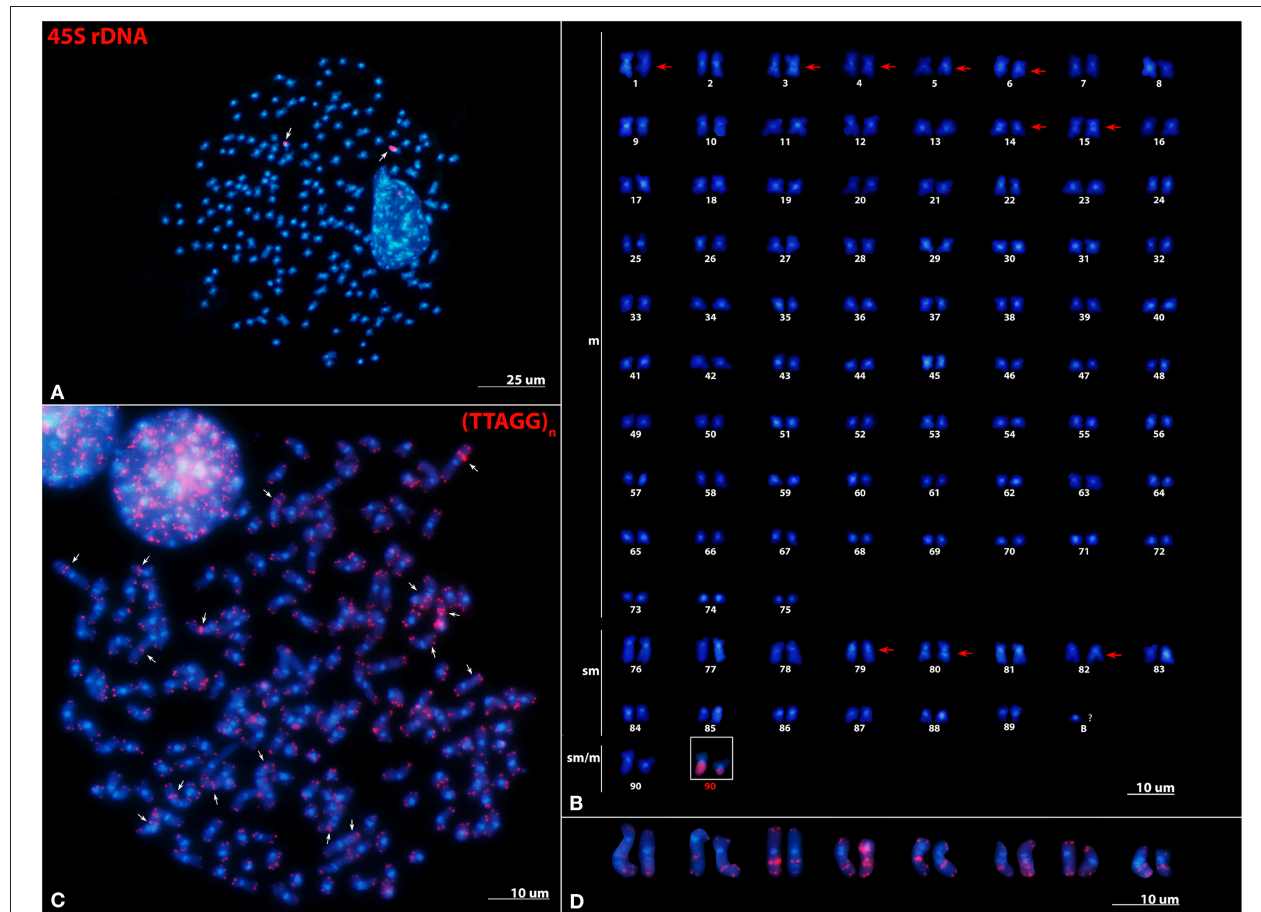
FIGURE 1 | Distribution of 45S rDNA and telomeric repeats on metaphase chromosomes of Pontastacus leptodactylus . (A) Mitotic metaphase and (B) karyogram of P. leptodactylus after FISH with 45S rDNA probe (red signals). m, metacentric chromosomes; sm, submetacentric chromosomes; sm/m, submetacentric/metacentric heteromorphic chromosome pair. Arrows point to interstitial HSs. 45S rDNA bearing heteromorphic chromosome pair is framed. (C) Mitotic metaphase of P. leptodactylus after FISH with telomeric repeats (TTAGG) n (red signals). ITRs are marked with arrows. (D) Eight chromosome pairs possessing ITRs. Chromosomes are counterstained with DAPI. Scale bar = 10 µ